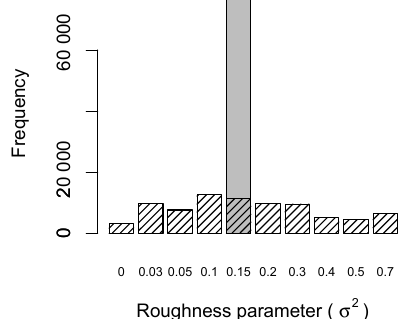
Figure 1. The response of the conventional “best-fit” approach to a synthetic signal with and without random measurement noise. The addition of noise to the synthetic signal results in a distribution of the roughness parameter (hatched bars), from which the true rough- ness cannot be inferred. This figure is to be compared to Fig. 11.